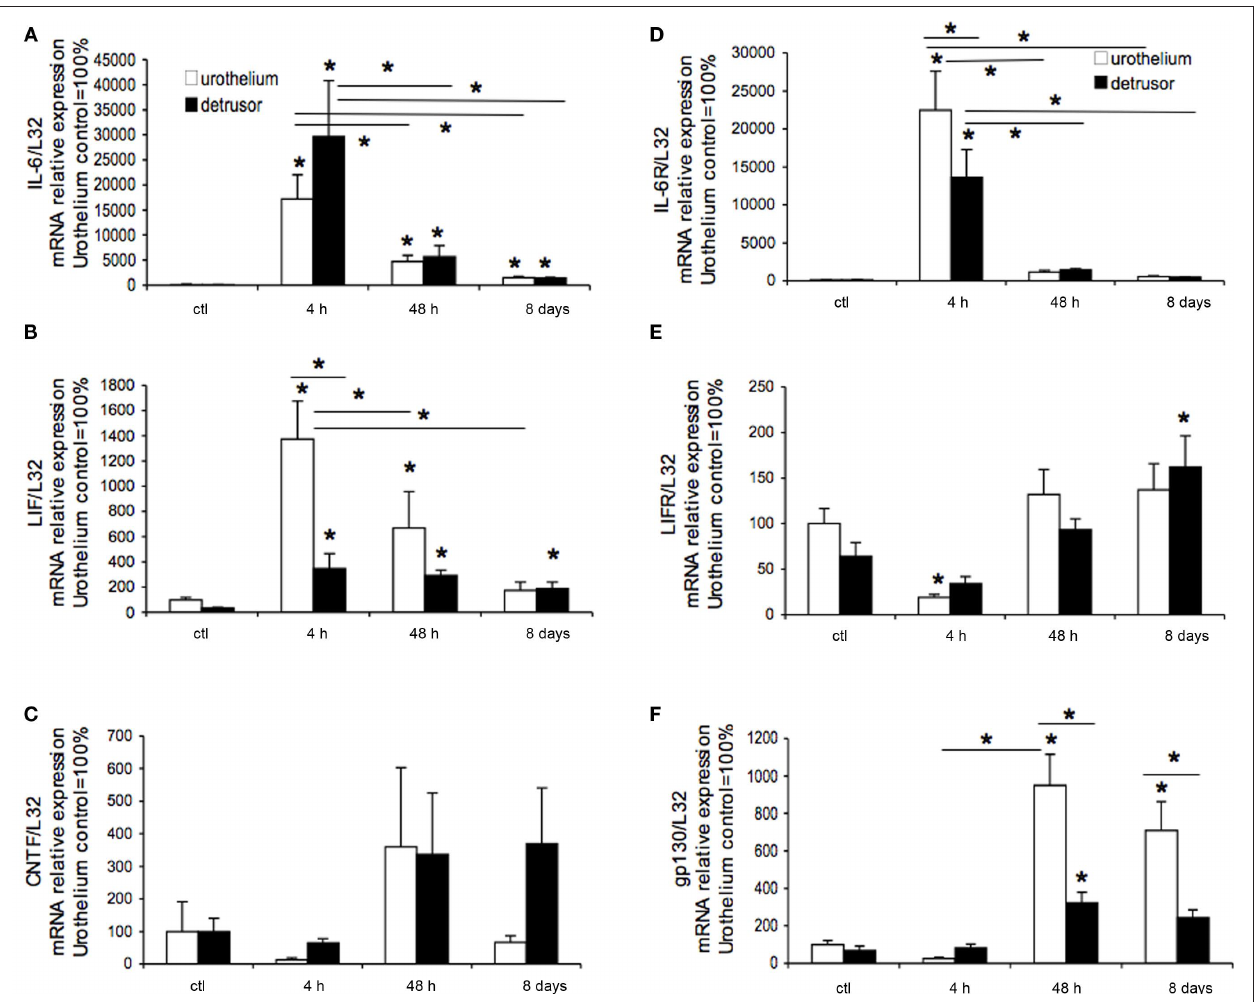
transcript expressed in urothelium and detrusor smooth muscle. Urothelium samples were set equal to 100% and normalized to the relative expression of the housekeeping gene, L32. Detrusor samples were expressed relative to urothelium samples and normalized to the relative expression of the housekeeping gene, L32. n = 6 for each group; * p ≤ 0.01 versus control or as indicated between groups by horizontal